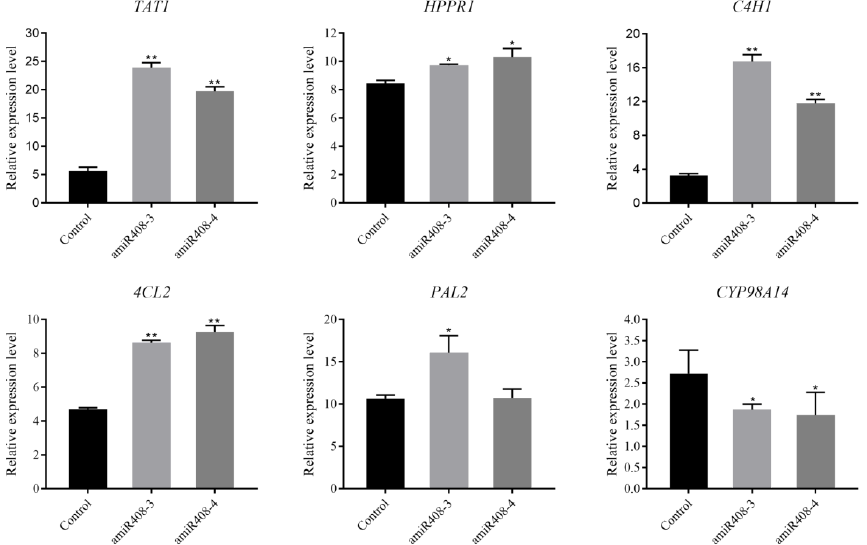
Figure 4. Relative expression levels of the key enzyme genes involved in phenolic acid biosynthetic pathway in the transgenic (amiR408) and control lines. All data are means of three independent experiments, with error bars representing SD. Significant differences in comparison with the control were determined by Dunnett’s multiple comparison test (** p < 0.01; * p < 0.05).